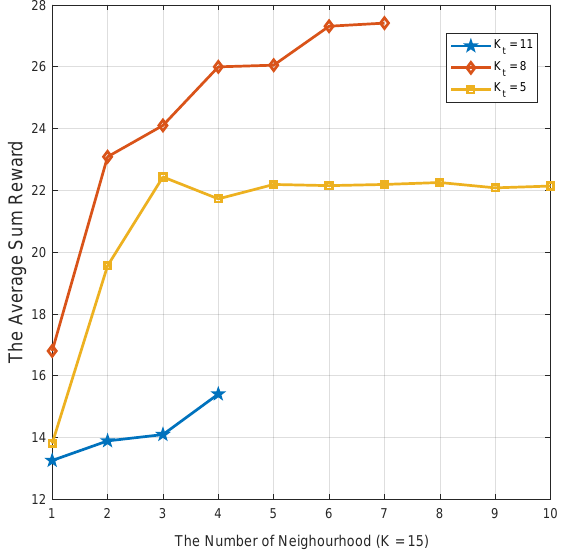
Figure 13. Performance comparisons with different